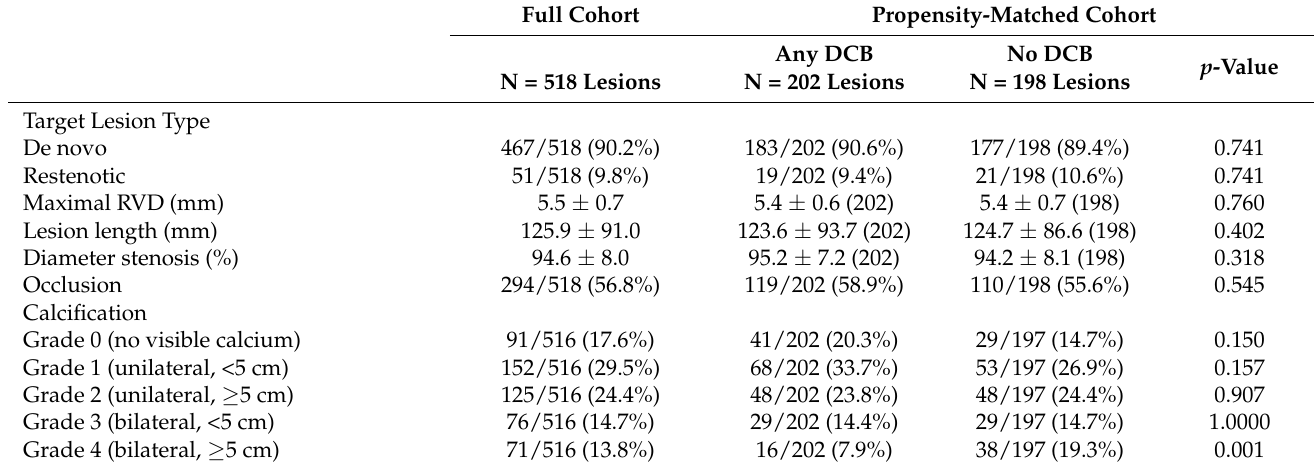
Table 2. Lesion characteristics.